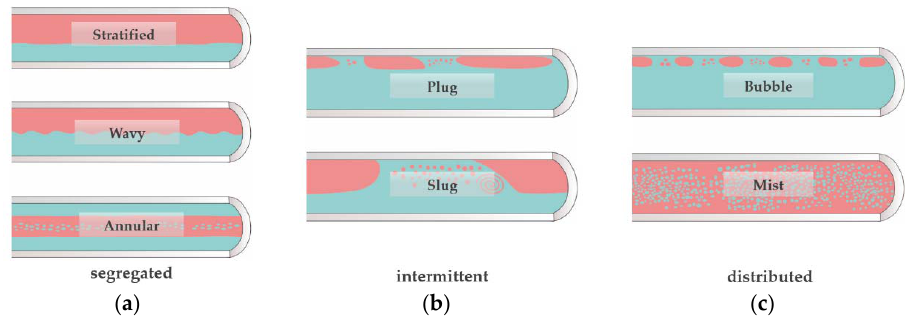
Figure 6. Schematics of different flow patterns: ( a ) segregated flow; ( b ) intermittent flow; ( c ) distributed flow.